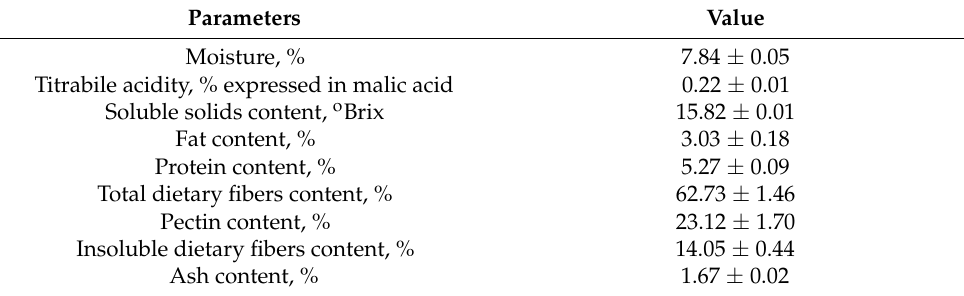
Table 2. Physicochemical parameters of the apple pomace powder. Parameters Value Moisture, % Titrabile acidity, % expressed in malic acid Soluble solids content, o Brix Fat content, % Protein content, % Total dietary fibers content, % Pectin content, % Insoluble dietary fibers content, % Ash content,